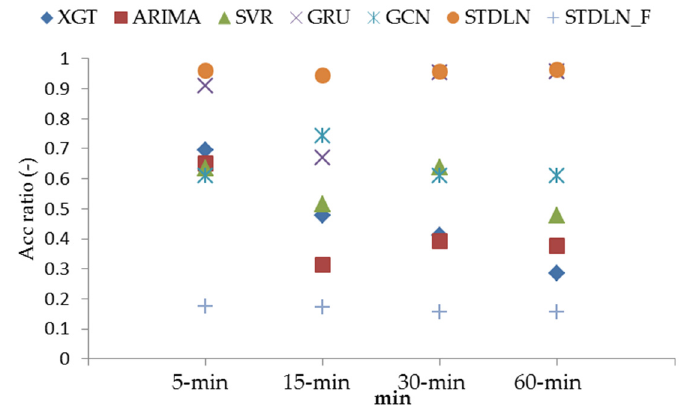
Figure 8. The scatter diagram of the Acc for all methods and all